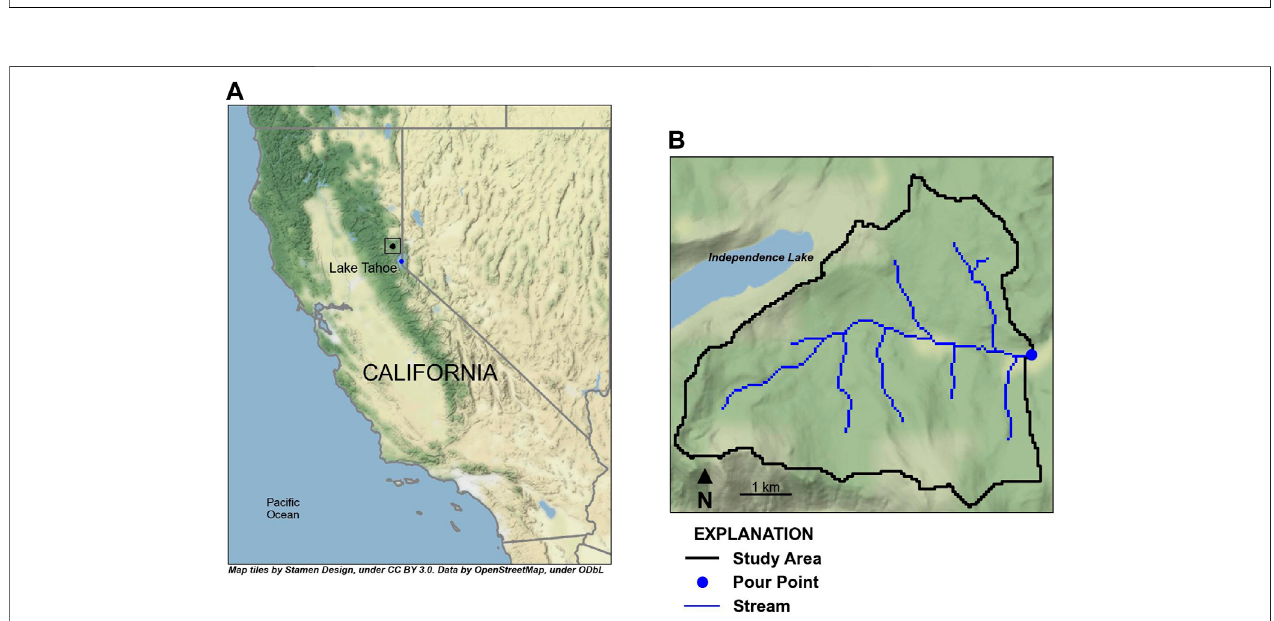
FIGURE 5 | Stream network generation from pyGSFLOW (blue lines) and ArcGIS Pro ’ s Flow Direction and Flow Accumulation tools (red lines) show that both methods are able to create representations of the Russian River watershed ’ s drainage pattern (A) . Some differences in the two stream network representations are observed in low-relief areas throughout the watershed (B) .